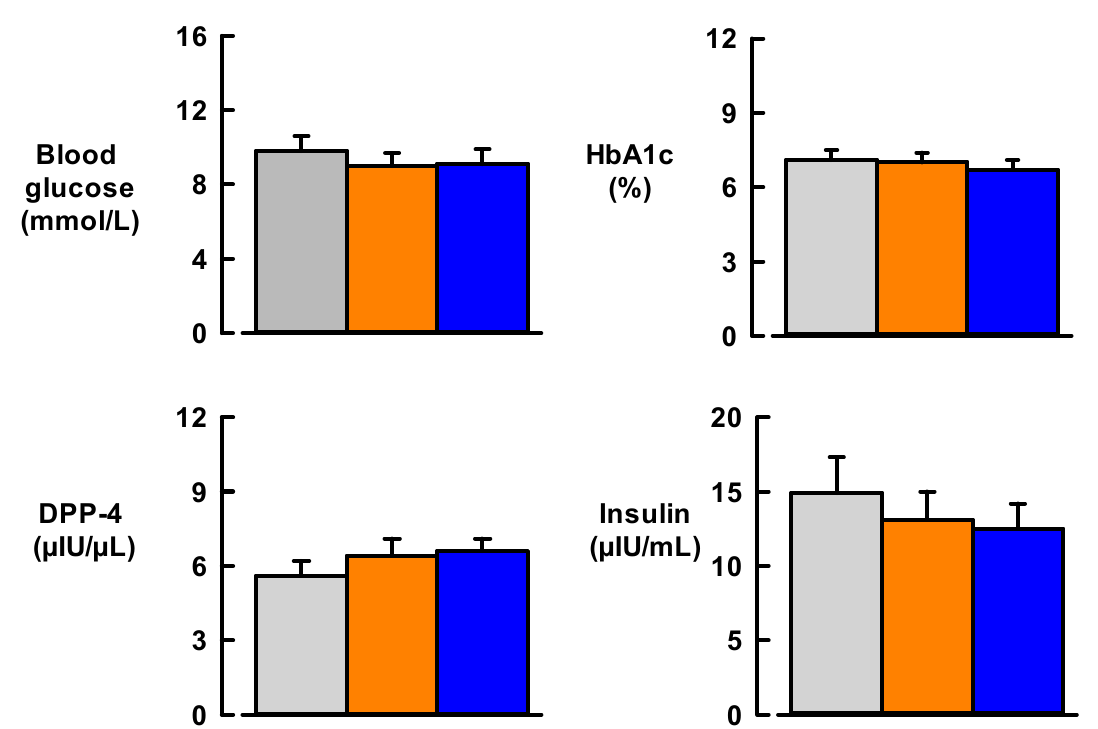
Figure 2. Effect of 12-week Mediterranean diet intervention (blue bars) or usual diet (orange bars) on glycaemic status compared with baseline levels (Grey bars) in participants with type 2 diabetes. Sample size, N = 19. Data are mean ± SEM. HbA1c, haemoglobin A1c; DDP4, dipeptidyl-peptidase 4. For insulin (1 µ IU/mL = 6.945